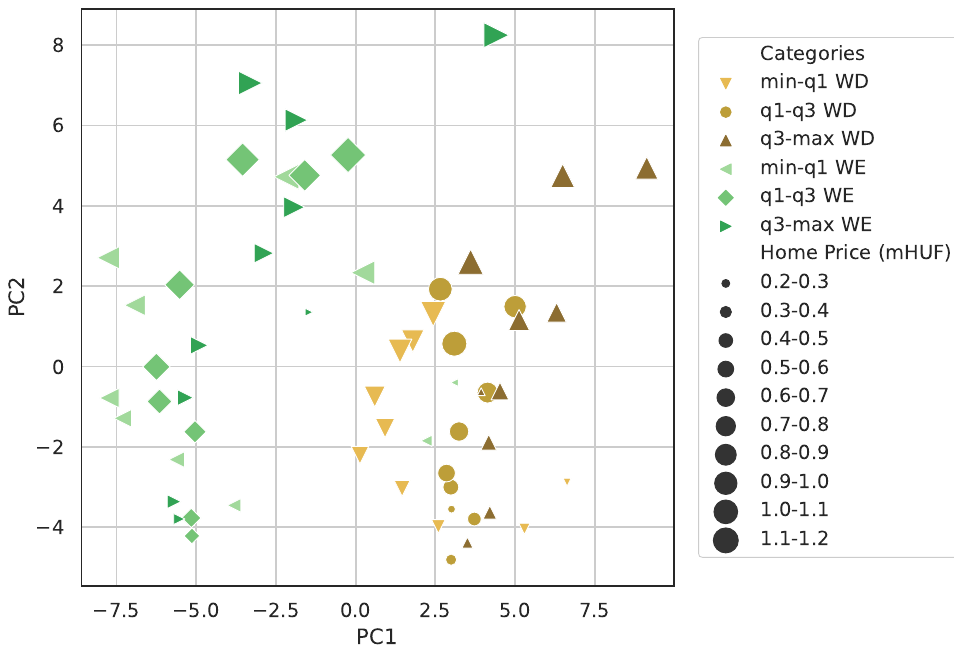
Figure 14. Scatter plot of the 2-component PCA. Marker sizes indicates the HomePrice category, the color/type WorkPrice category and also the day type